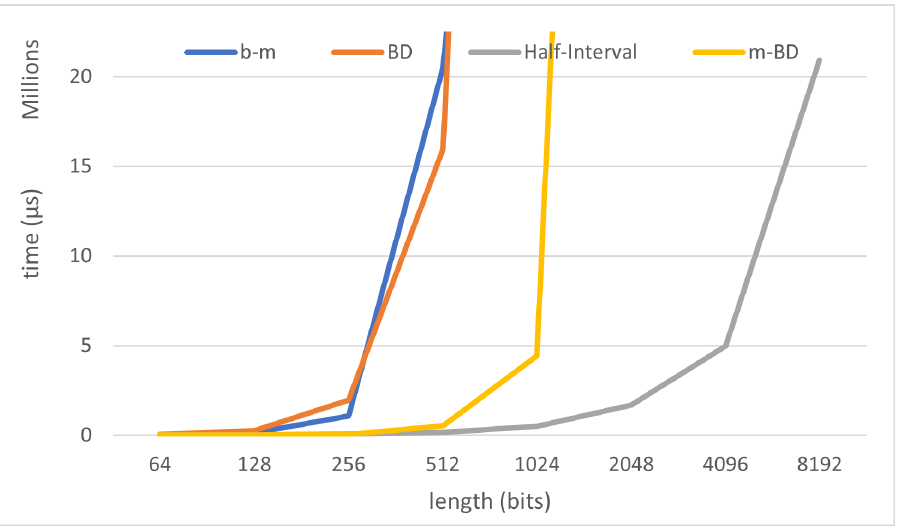
Figure 3. Comparison between the algorithms in the LC calculation for all the possible GSS-sequences of a given length (Half-Interval